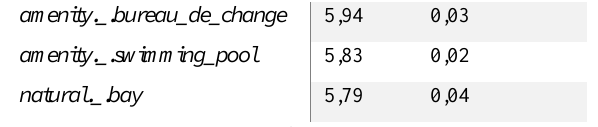
Table 3: Random forest important tags Based on the random forest model the world vulnerabilities are calculated and mapped in Figure 9